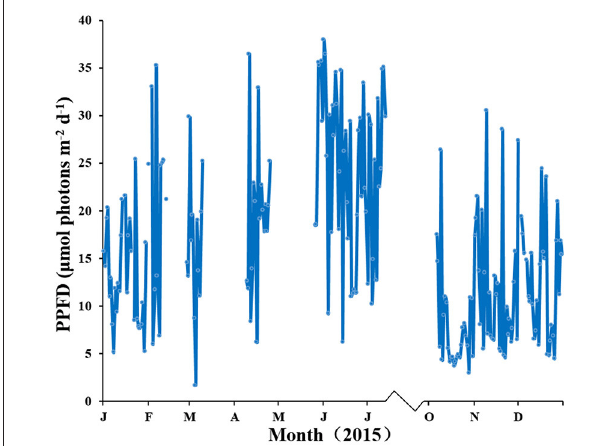
FIGURE 3 | Light intensity of the canopy of Zostera marina in Swan Lake (SLL) during the study period.